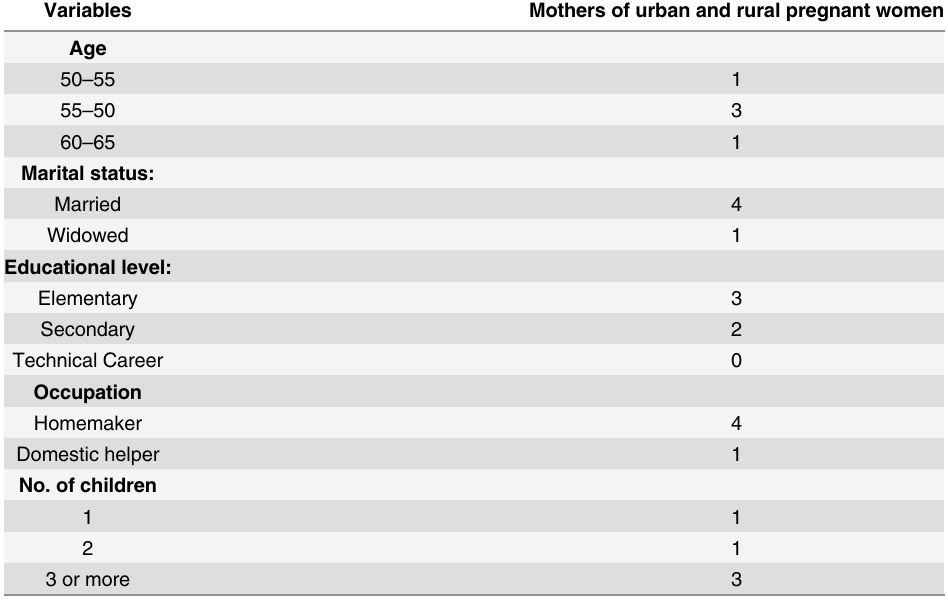
Table 4. Socio-demographic characteristics of the sample: mothers of urban and rural pregnant